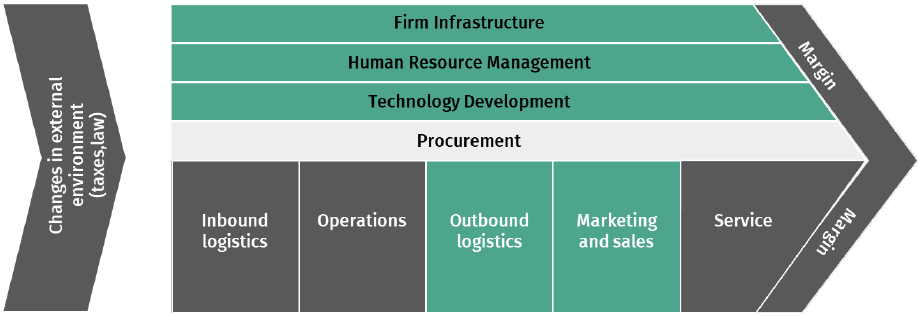
Figure 5. Value chain model activities assessment based on correlation analysis.